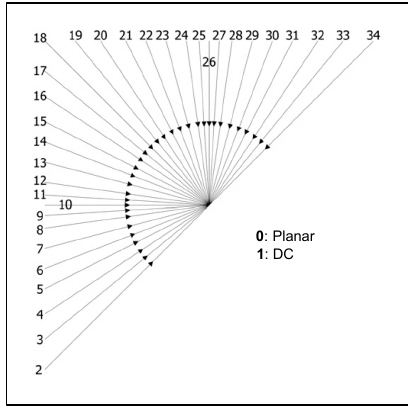
Figure 3. Directional prediction modes of Intra coding scheme proposed for JEM-DVC.